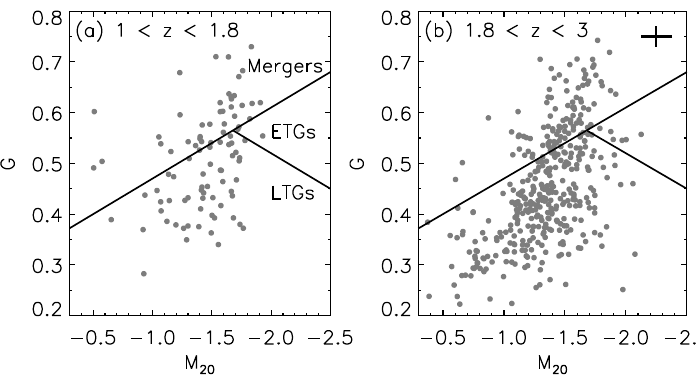
Fig. 8. Distribution of the rest-frame optical ( (cid:24) 5000 ˚A) morphologies of ULIRGs in the Gini coefficient vs. M 20 plane. The solid lines represent the criteria defined by Lotz et al. (2008). Early-type galaxies (ETGs, E/S0/Sa): G (cid:20) (cid:0) 0 : 14 M 20 + 0 : 33 and G > 0 : 14 M 20 + 0 : 80; Late-type galaxies (LTGs, Sb (cid:0) Ir): G (cid:20) (cid:0) 0 : 14 M 20 + 0 : 33 and G (cid:20) 0 : 14 M 20 + 0 : 80; Mergers: G > (cid:0) 0 : 14 M 20 + 0 : 33. Typical error bars for the data points are shown in the right